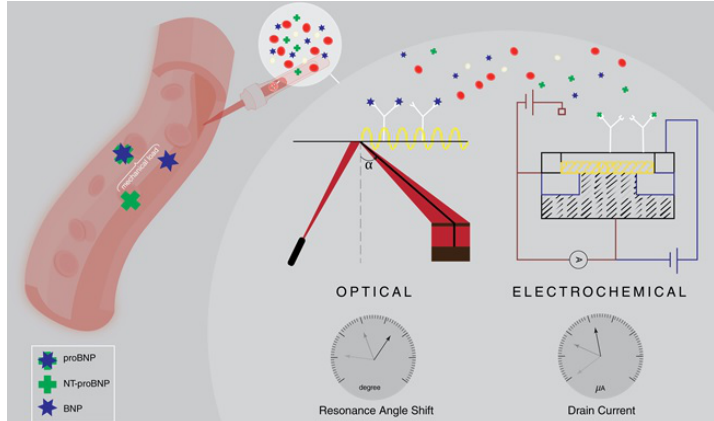
Figure 2. Electrochemical and optical nanobiosensing of BNP and